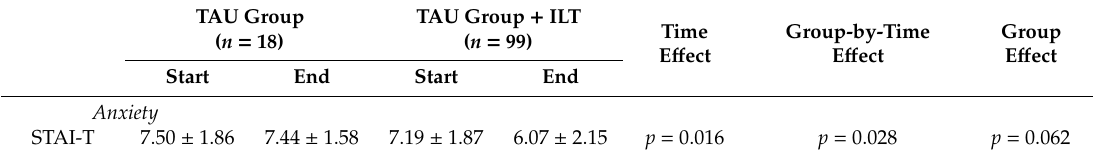
Table 5. Scores on the Trait-Anxiety Subscale (STAI-T) at the start and completion of the day hospital treatment by